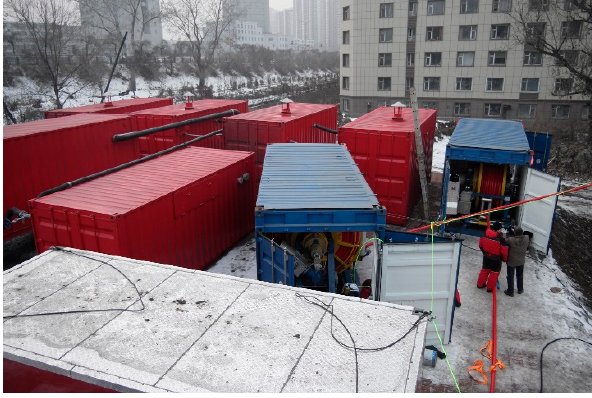
Figure 2. Chinese hot water drilling engineering.